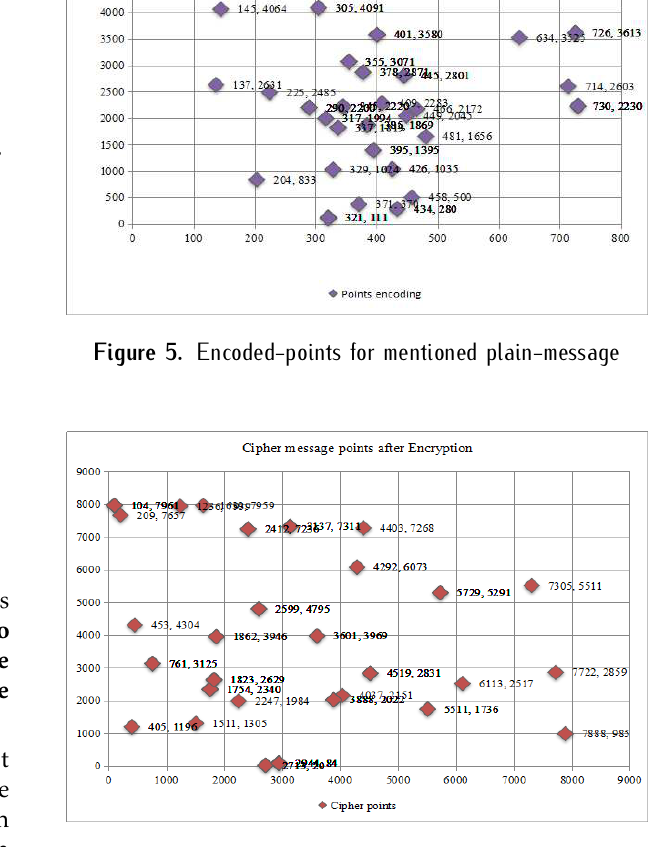
Figure 6. Cipher-points for above mentioned